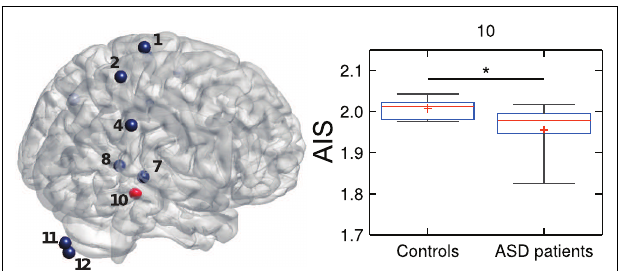
FIGURE 5 |AIS inASD patients compared to controls . (Left) Investigated MEG source locations (spheres; red = significantly lower AIS in ASD, blue = not sign.). (Right) Box and whisker plot for LAIS in source 10 (Hippocampus, corresponding to red sphere), where significant differences in AIS between patients and controls were found. Modified from Gomez et al. (2014); creative commons attribution license (BB CY